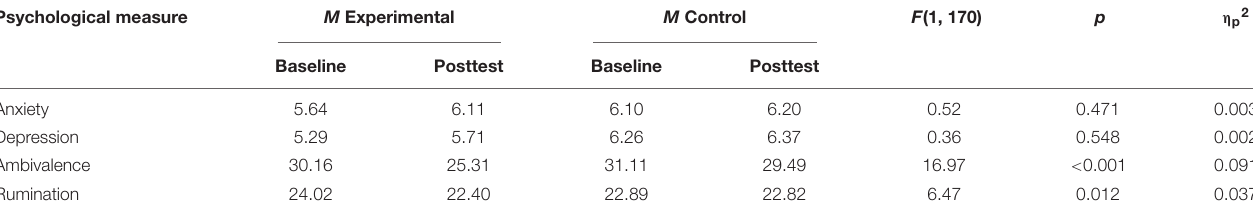
TABLE 6 | One-way repeated measures MANOVA between groups for wellbeing measures. Psychological measure M Experimental